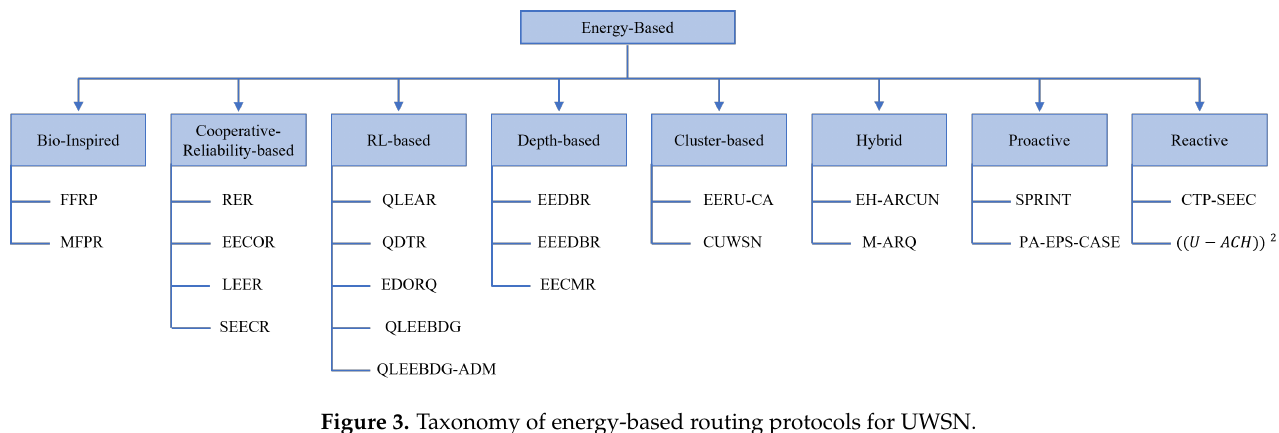
Figure 3. Taxonomy of energy-based routing protocols for